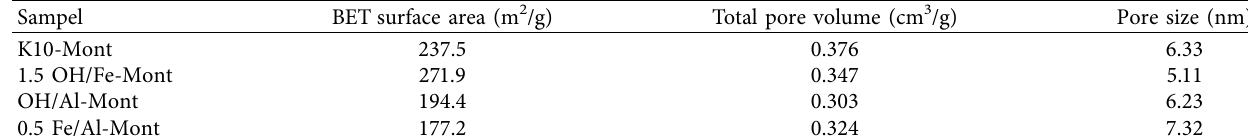
Table 1: Surface area: pore volume and pore size of montmorillonites.